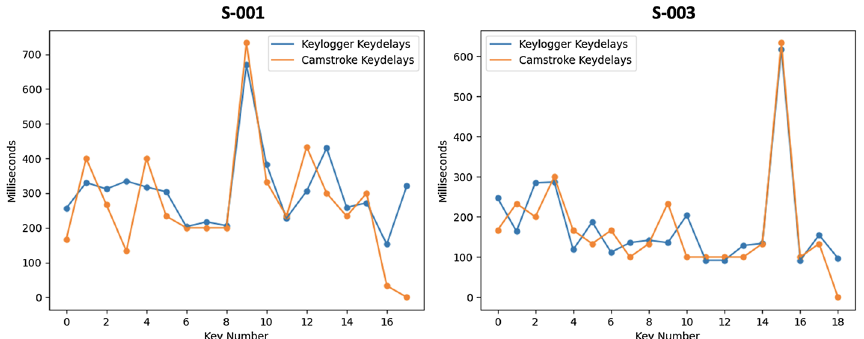
Fig. 12 Best KeyDelay comparison for greeting sentence sample group